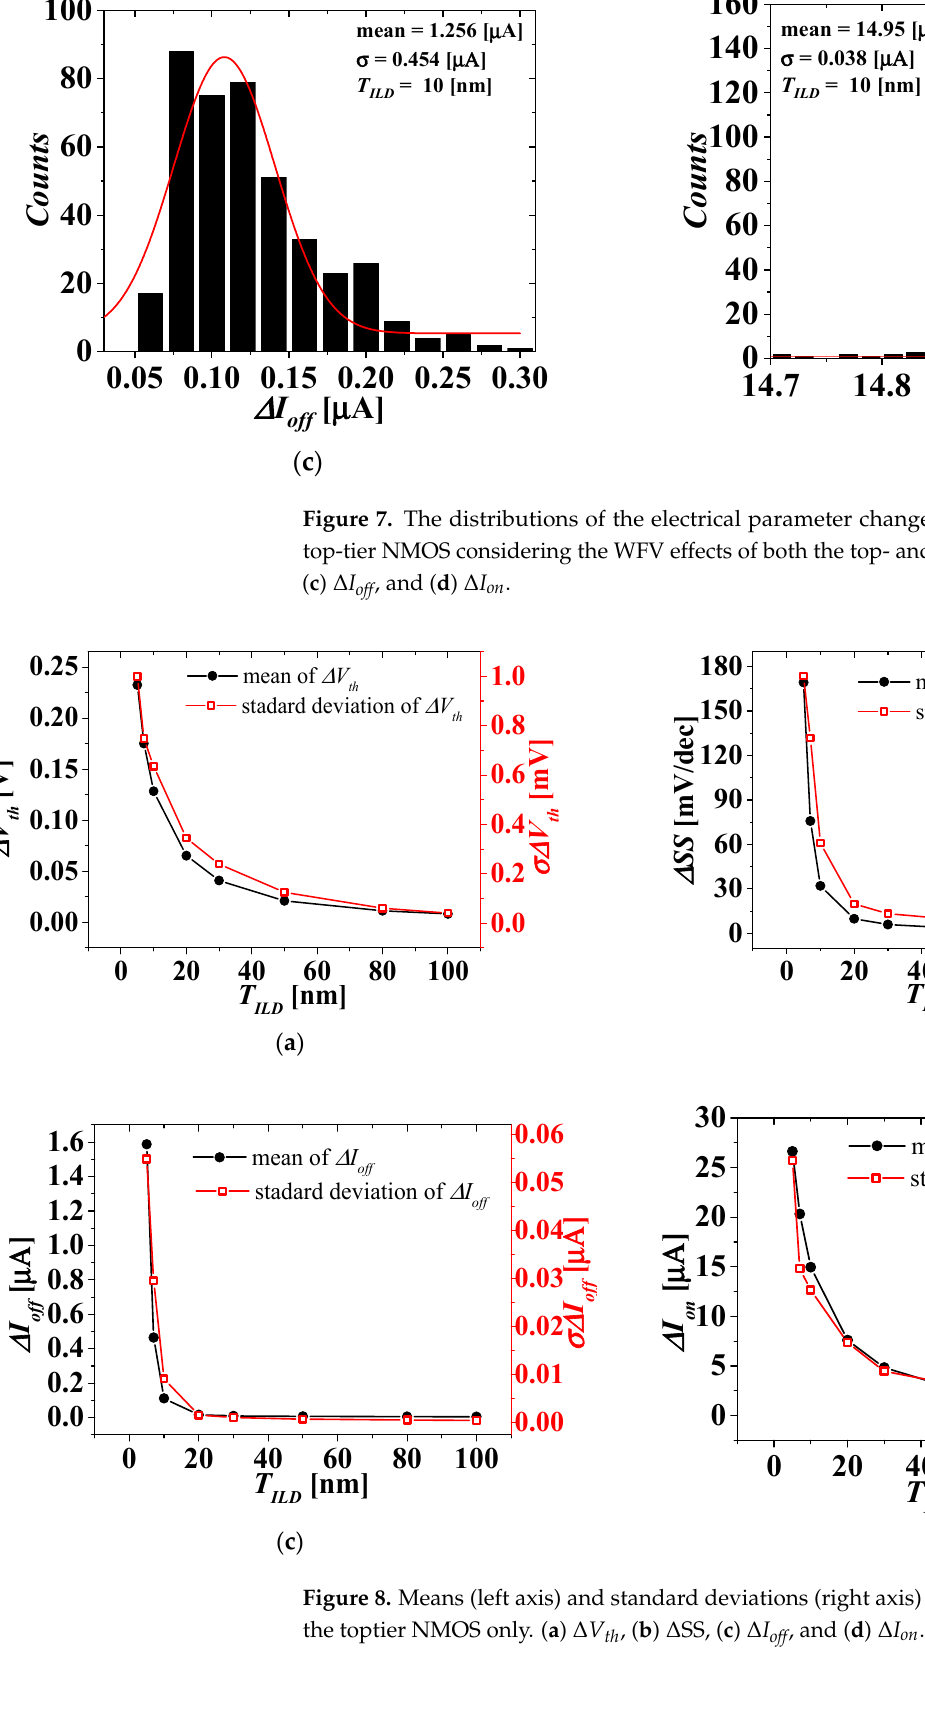
Figure 8. Means (left axis) and standard deviations (right axis) considering WFV on the TiN gate of the toptier NMOS only. ( a ) Δ V th , ( b ) Δ SS, ( c ) Δ I off , and ( d ) Δ I on .